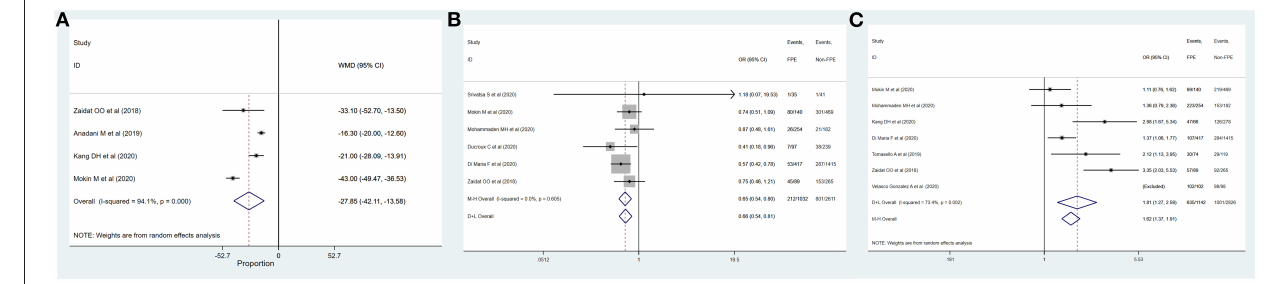
FIGURE 5 | Determinants of achieving complete recanalization with FPE. (A) Duration of intervention; (B) general anesthesia; (C) use of